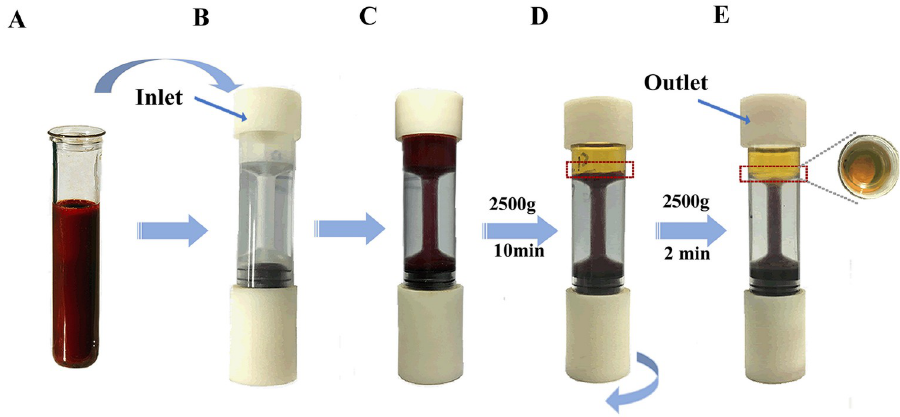
Fig 3. Processing of leukocytes by LSA-3 designs pulling style method. (A) 2–3 ml of whole blood was being prepared. (B) The LSA-3 is assembled. (C) the blood is introduced in the upper funnel chamber. (D) The buffy coat (red rectangle) is formed at 2500g for 10min centrifugation conditions. (E) with clockwise rotate the threaded-booster cause the buffy coat (red rectangle) moving down to a specific location within the upper